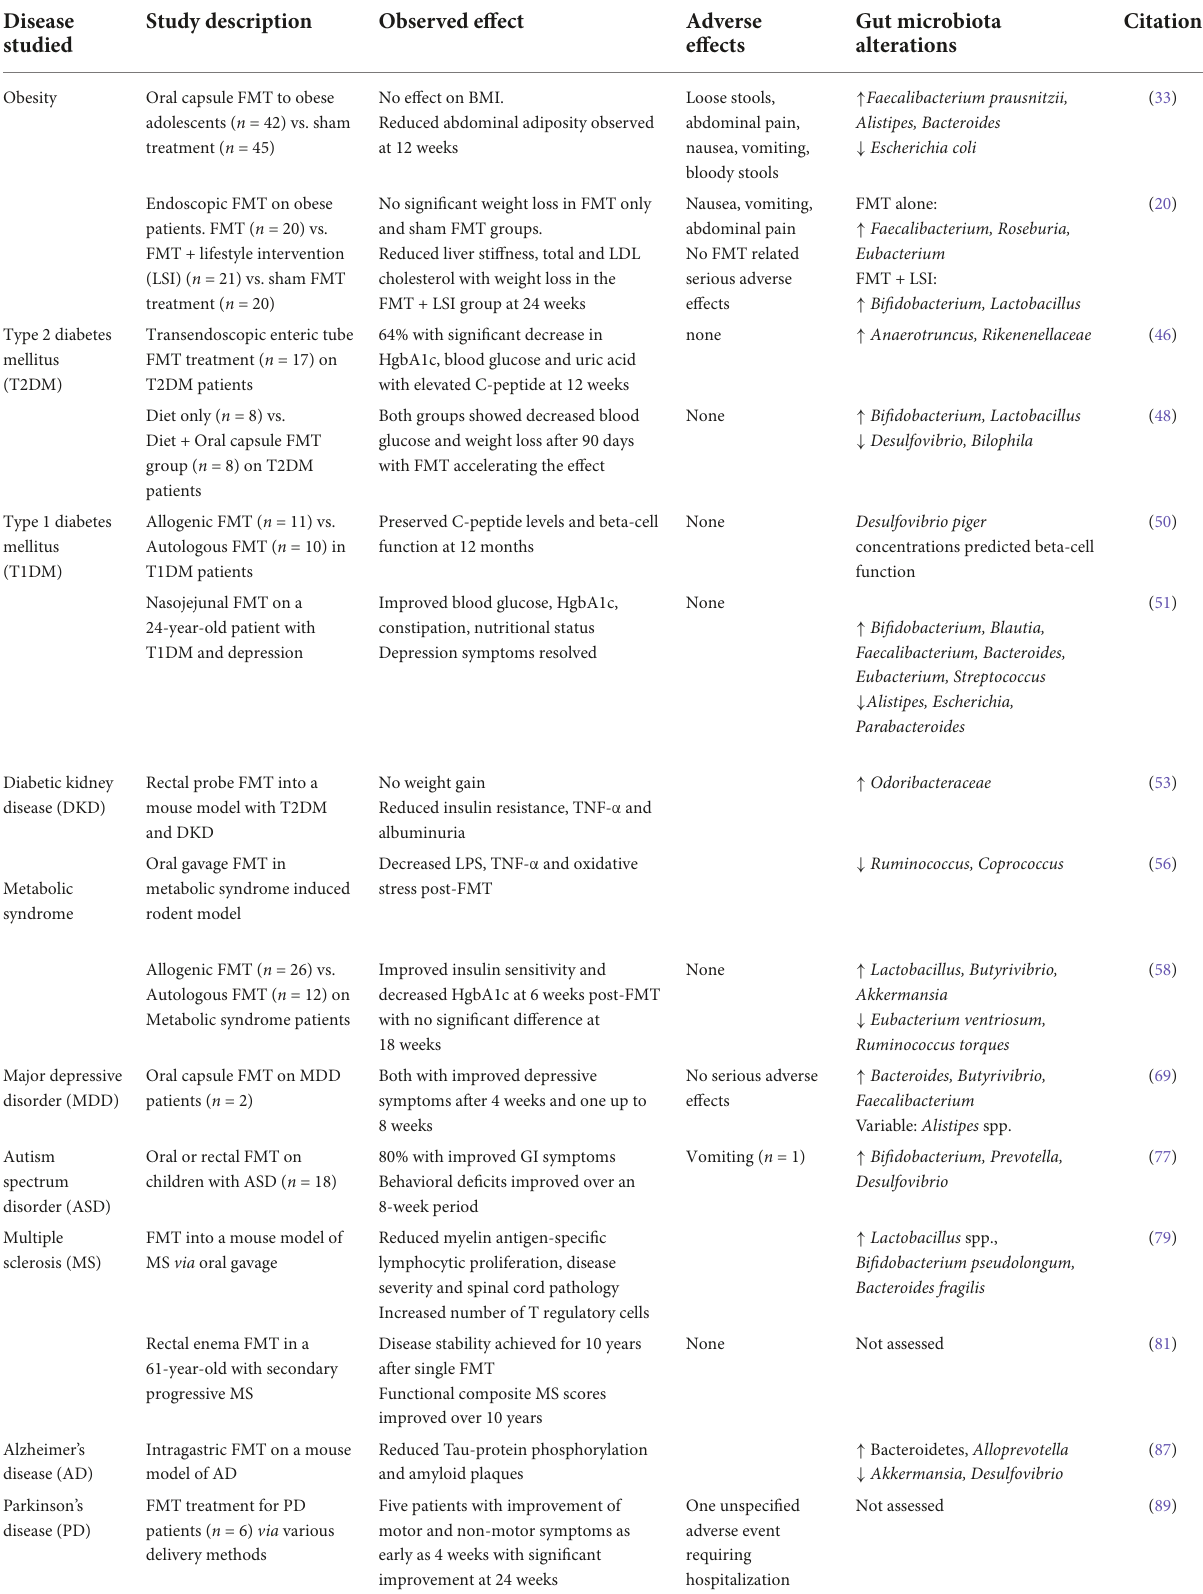
TABLE 1 Comparison between FMT